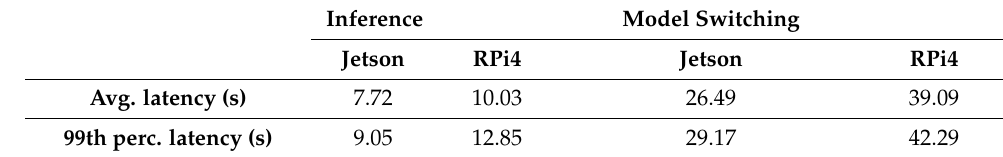
Figure 10. Results of model switching latency. Table 2. Latency in model switching tests.